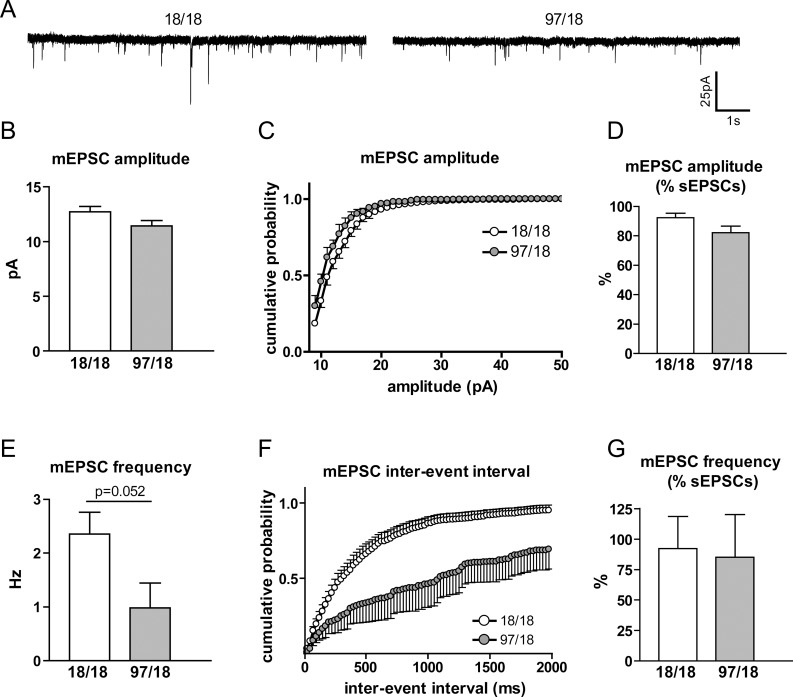
mEPSC amplitude and frequency change in Hu97/18 SPNs.Cells were patch-clamped with potassium-based internal solution at Vh = -70 mV and the initial sEPSCs were recorded. Then, TTX was added to the external solution which allowed for the extraction and analysis of mEPSCs. (A) Representative mEPSC traces for Hu18/18 (left) and Hu97/18 SPNs (right). (B) The average mEPSC amplitude of Hu18/18 and Hu97/18 cells (p = 0.1). (C) Cumulative probability showed a decrease in sEPSC amplitude in Hu97/18 SPNs (significant genotype and amplitude interaction, p<0.0001). (D) mEPSC amplitude presented as a percentage of the initial sEPSC amplitude. There was no difference between Hu18/18 and Hu97/18 SPNs. (E) The mean mEPSC frequency trended towards a decrease in Hu97/18 SPNs but did not reach statistical significance (p = 0.052). (F) Cumulative probability showed an increase in mEPSC inter-event intervals in Hu97/18 SPNs (significant genotype and inter-event intervals interaction, p<0.0001). (G) mEPSC frequency presented as a percentage of the initial sEPSC frequency. There was no difference between Hu18/18 and Hu97/18 SPNs. For all experiments, Hu18/18 n = 9 and Hu97/18 n = 5.